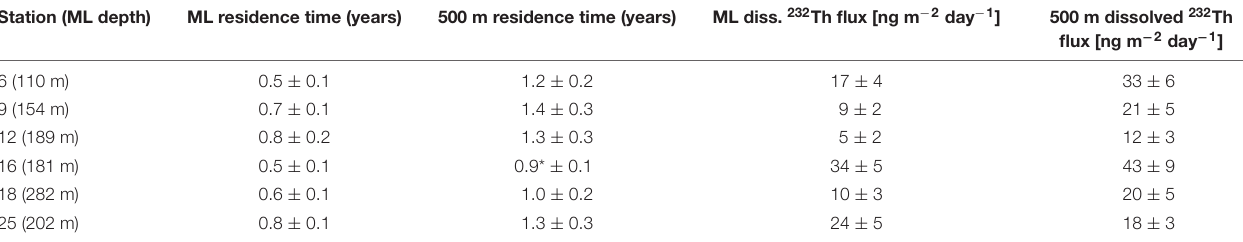
TABLE 3 | Comparison between residence time and 232 Th fluxes in the mixed layer (ML) depth and at 500 m during the HEOBI voyage. Station (ML